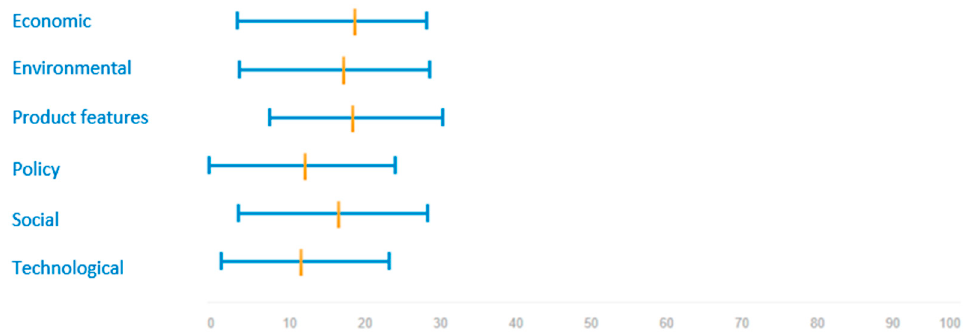
Figure 4. Weights assigned to each criterion (economic, environmental, features for consumers, policy, social, technological) (%) (all stakeholders’ views). The orange cross-line shows the mean value. The blue horizontal line shows the range between lowest and highest weights attached to each criterion.